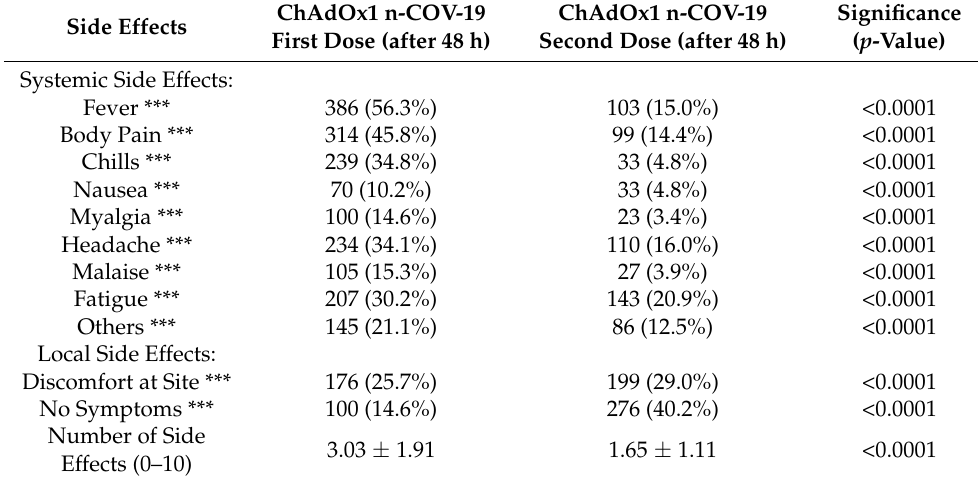
Table 2. Prevalence of systemic and local adverse side effects by ChAdOx1 n-CoV-19